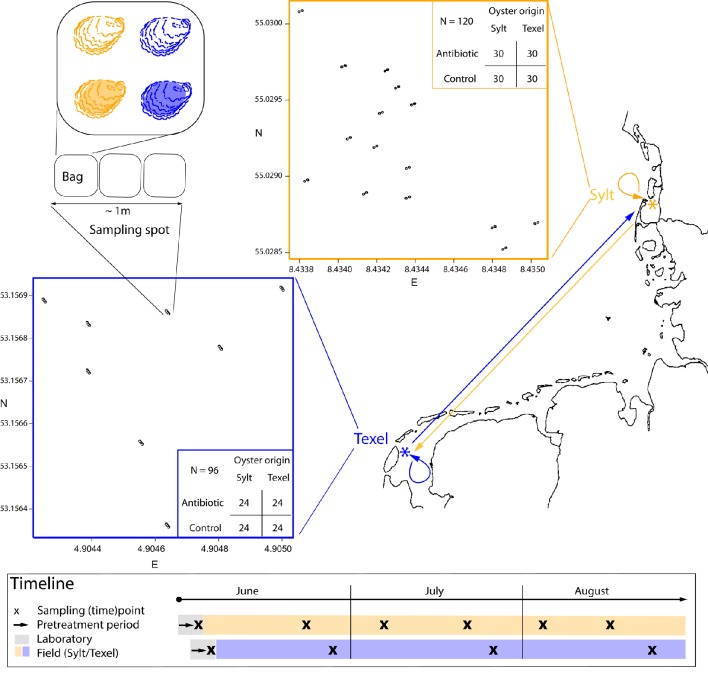
Experimental design and timeline. The spatially stratified sampling design is described on the map. The experimental sites (orange = Sylt, blue = Texel) are marked by an asterisk (*). The arrows on the map link the oyster collection sites with the deployment sites (i.e., half of the oysters were returned to their collection site while the other half was transplanted). The inserted plots show within-site deployment scheme with all sampling spots. Within each sampling spot there are two (Sylt) or three (Texel) bags with four oysters each. Each oyster in the bag belongs to one of the four treatment groups (i.e., antibiotic treatment/control × Sylt/Texel oyster origin). Note that the colors (orange = Sylt, blue = Texel) can denote site or the oyster origin, depending on the context. Tables show the total and the per treatment sample sizes for each site. The box below the map shows the sampling timeline for both sites.